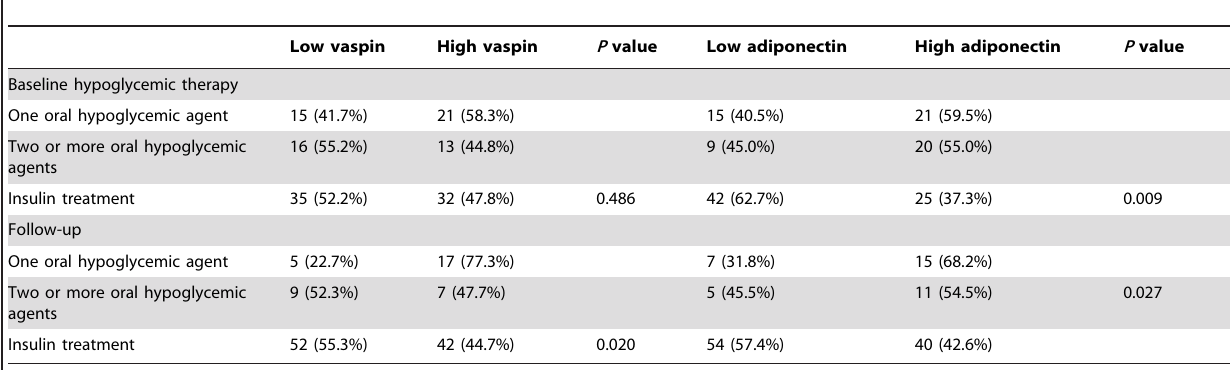
Table 4. Medicine treatment in T2DM group with low or high vaspin and adiponectin levels at baseline and follow-up.